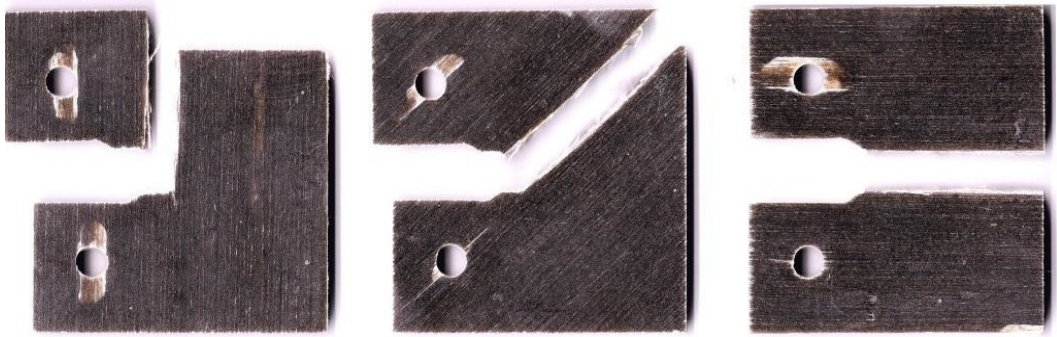
Figure 5: Compact tension specimens with different directions after cyclic loading (fibre volume fraction 35%).